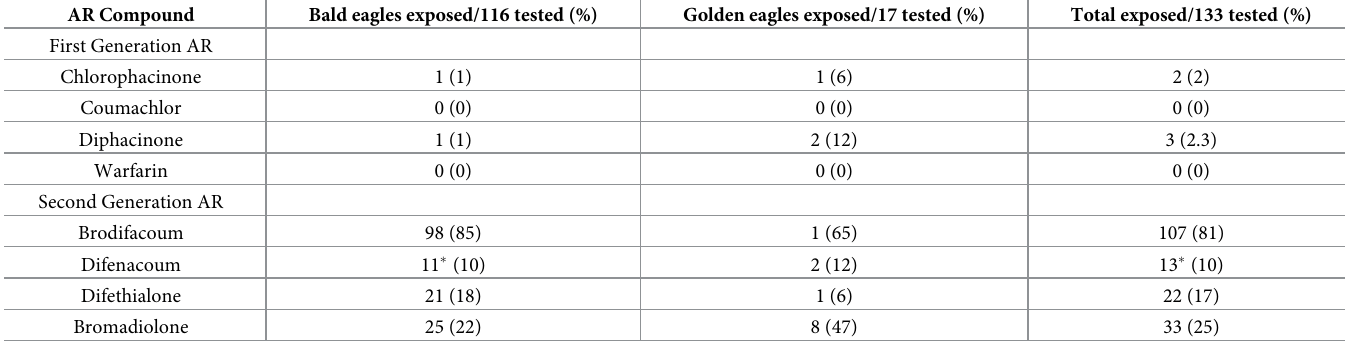
Table 2. The frequency of eight anticoagulant rodenticide (AR) compounds detected in 116 bald eagles and 17 golden eagles submitted to the Southeastern Cooper- ative Wildlife Disease Study (University of Georgia), 2014–2018. AR Compound Bald eagles exposed/116 tested (%) Golden eagles exposed/17 tested (%) Total exposed/133 tested